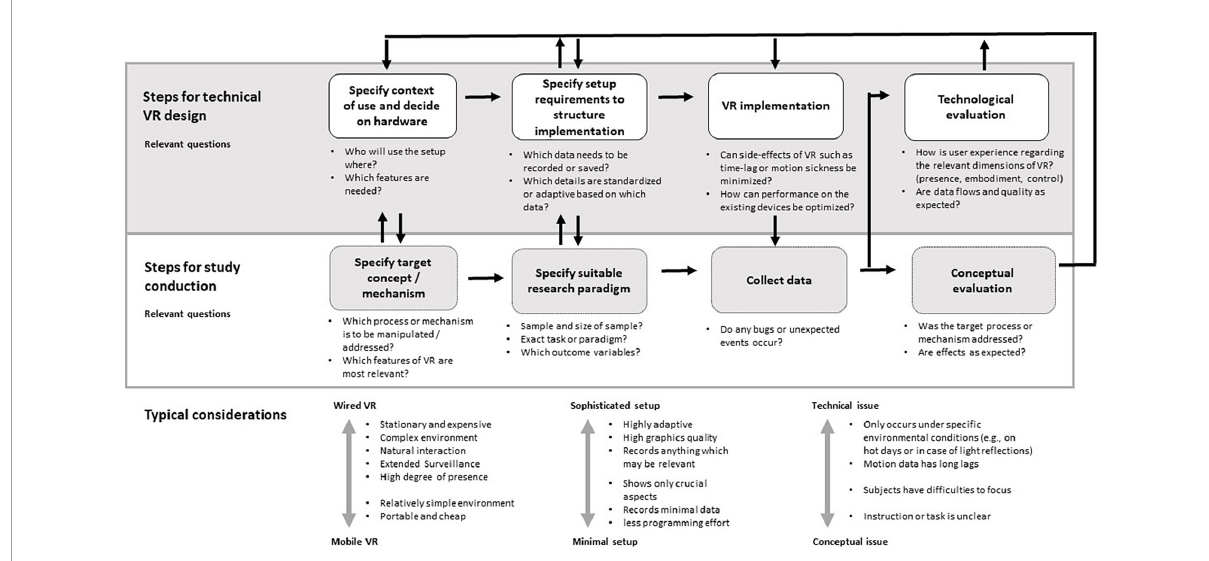
FIGURE2 Pipeline for user-centered design of virtual reality (VR) setups for clinical research, helpful questions to discuss for the respective steps and typical